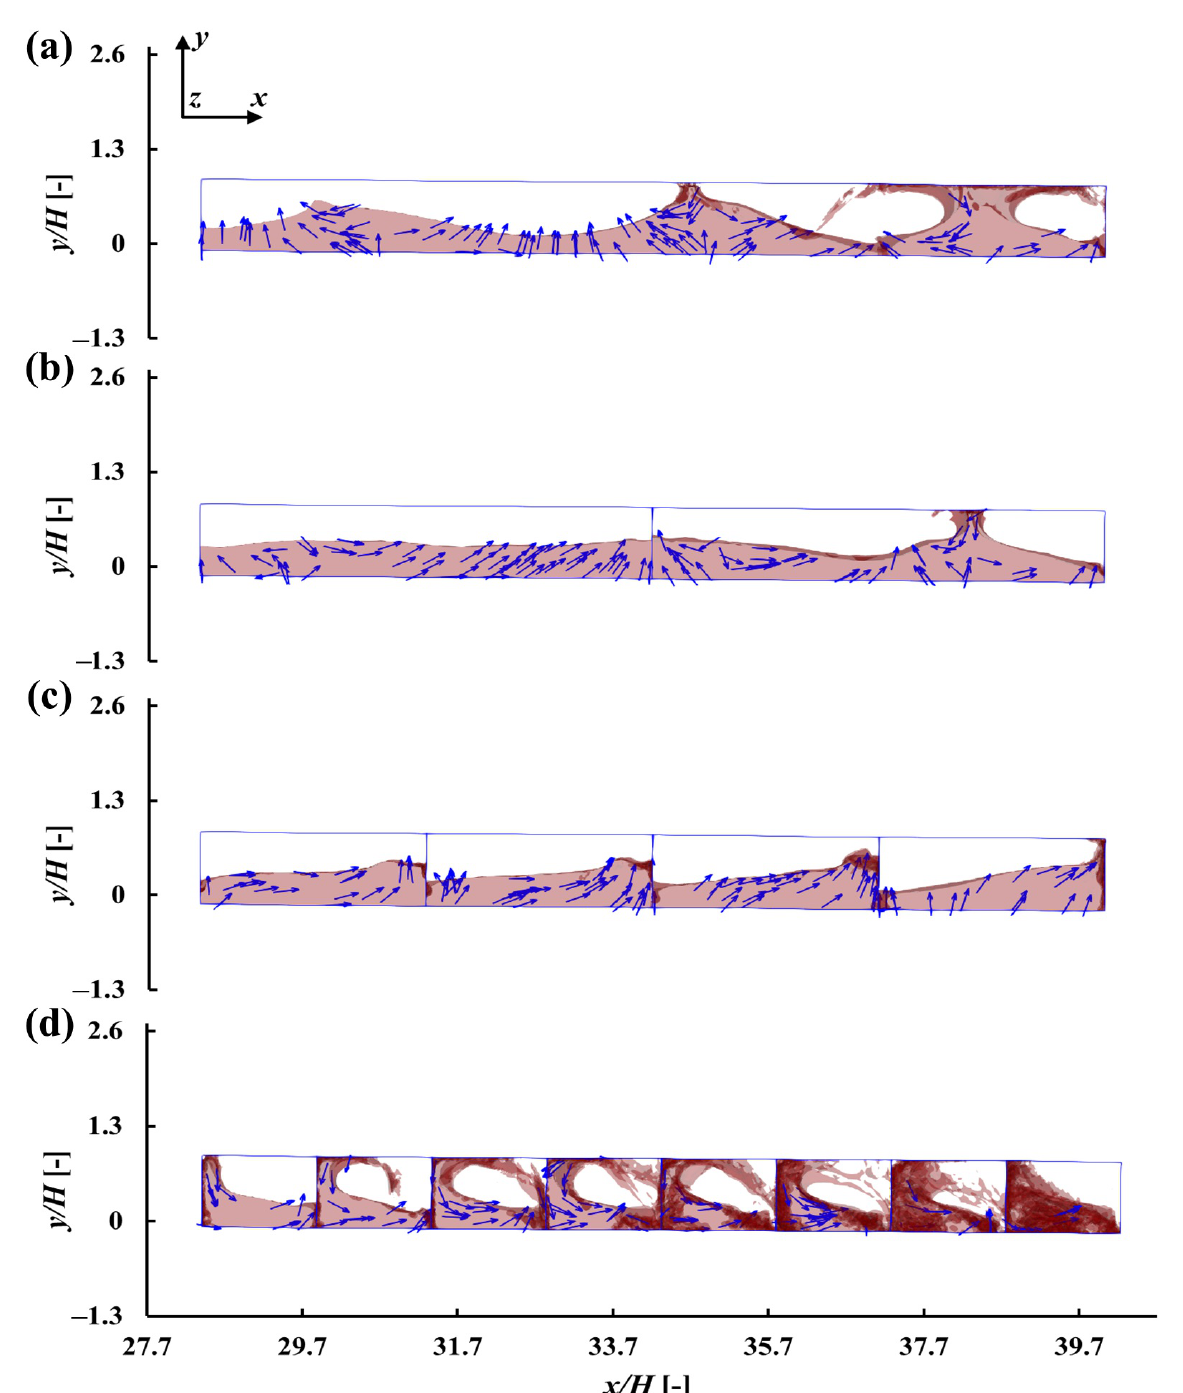
Figure 14. Snapshots for the sloshing tank with D i = 0.25 at t / T = 5.0 for ( a ) N c = 1, ( b ) N c = 2, ( c ) N c = 4 and ( d ) N c = 8. Water phase is shown as transparent red with dark red representing the free surface. Blue arrows show the general direction of motion of the sloshing